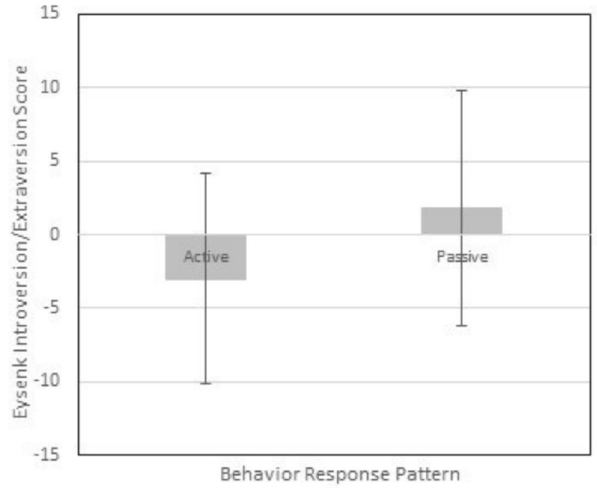
Figure 2. Introversion/Extraversion scores of participants with active and passive BR patterns. Mean and standard deviation of the Introversion/Extraversion axis scores of the EBQ-BV for participants categorized as having active or passive behavior response patterns according to the quadrant with the highest raw score on the